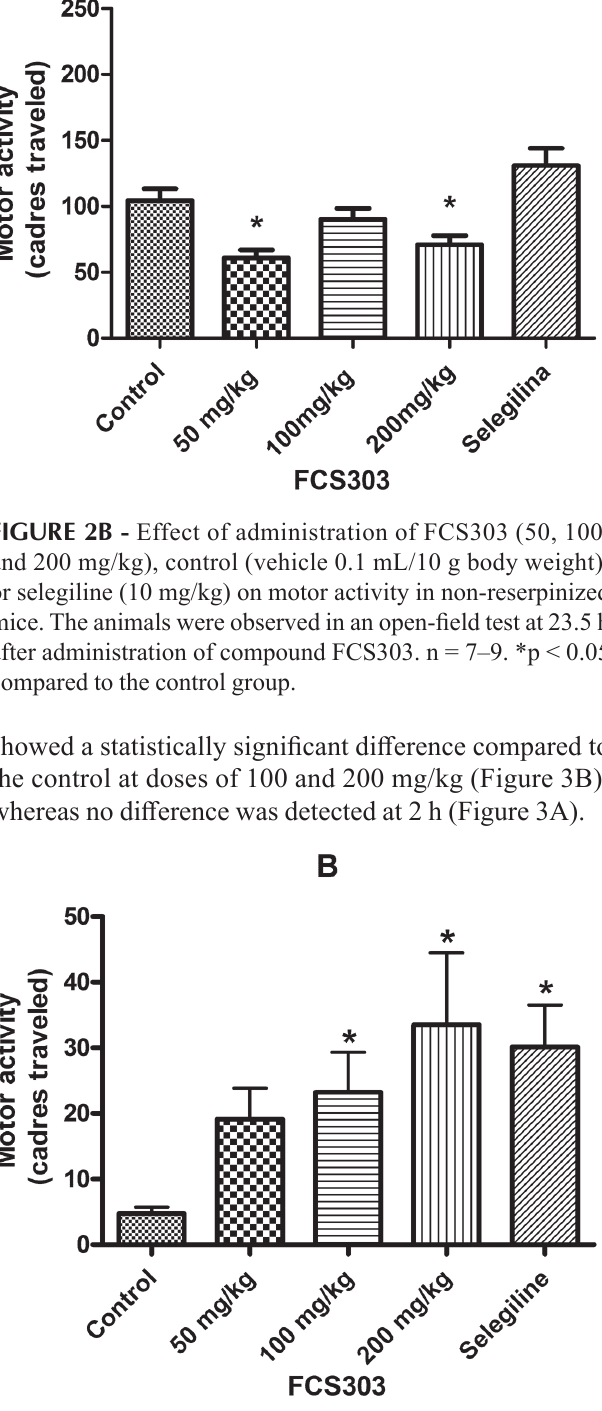
FIGURE 3A - Effect of administration of FCS303 (50, 100, and 200 mg/kg), control (vehicle 0.1 mL/10 g body weight), or selegiline (10 mg/kg) on motor activity in mice treated with reserpine (3 mg/kg). The animals were observed in the open- field test 2 h after administration of reserpine. n = 7–9. *p < 0.05 compared to the control group.